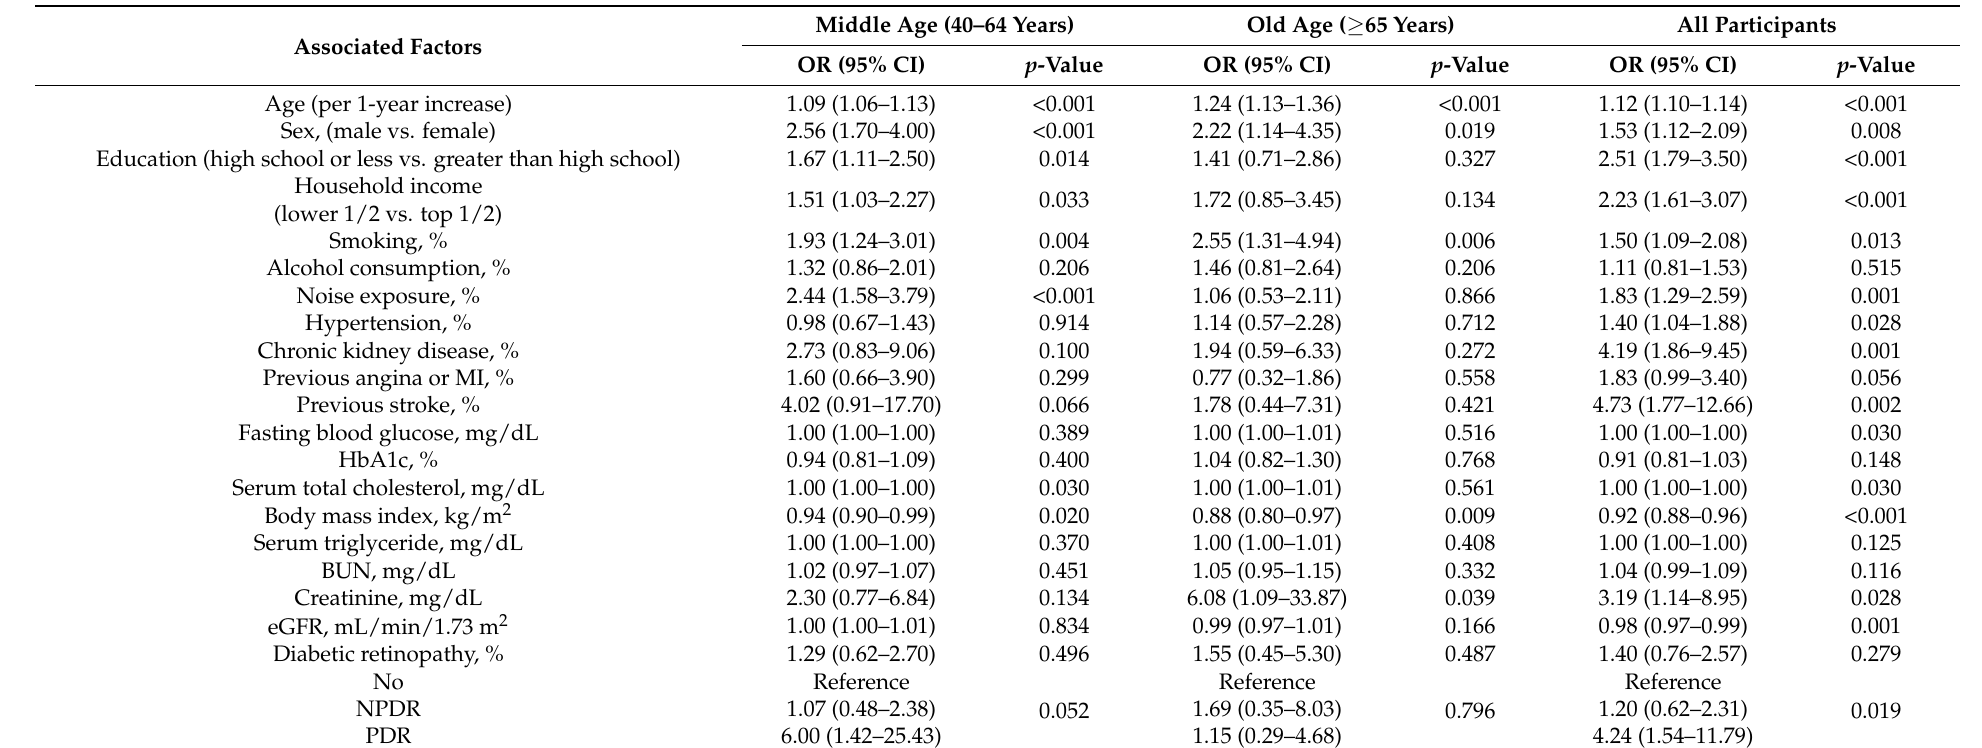
Table 3. Univariate logistic regression analyses for the association between factors and hearing loss in all participants and according to age group. Associated